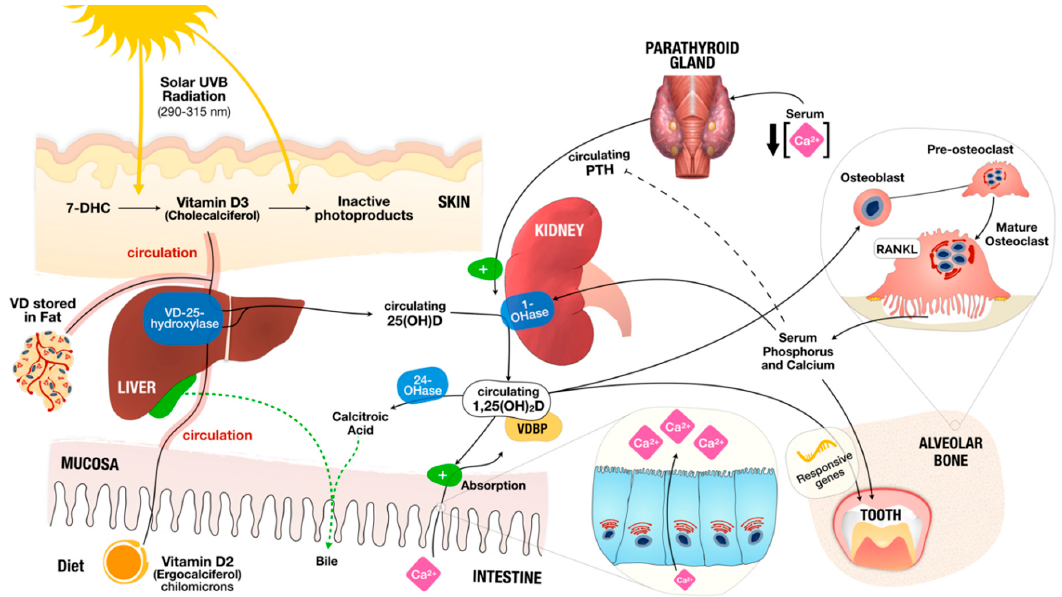
Figure 1. Vitamin D and Calcium, Phosphorus and Bone Metabolism. Vitamin D is obtained mostly from sunlight exposure (Vitamin D3) and from diet (Vitamin D2). In contact to solar ultraviolet B (UVB) radiation, 7-dehydrocholesterol (7-DHC) present in the skin is immediately converted to vitamin D3 in a heat-dependent process. Excessive sunlight exposure can destroy Vitamin D3 and convert it into inactive photoproducts. Vitamin D2 from diet is absorbed in the form of chylomicrons when they spread into the bloodstream as Vitamin D (encompassing Vitamin D2 or D3). Vitamin D in the circulation is bound to the vitamin D–binding protein (VDBP), which transports it to the liver. There, Vitamin D is converted by vitamin D-25-hydroxylase (VD-25-hydroxylase) to 25-hydroxyvitamin D (25(OH)D) (used as standard surrogate to determine vitamin D status). Then, 25(OH)D circulates, reaching the kidneys where it is activated by 25-hydroxyvitamin D-1 α hydroxylase (1-OHase) to 1,25-dihydroxyvitamin D (1,25(OH)2D). Serum phosphorus or calcium can impact renal production of 1,25(OH)2D. 1,25(OH)2D promotes negative feedback of parathyroid hormone (PTH) by the parathyroid glands. 1,25(OH)2D increases the expression of 25-hydroxyvitamin D-24-hydroxylase (24-OHase), upholding its excretion in the bile. 1,25(OH)2D is recognized in the osteoblasts, causing the induction of mature osteoclast through expression of the receptor activator of nuclear factor- κ B ligand (RANKL). Mature osteoclasts remove calcium and phosphorus from the bone, maintaining the serum levels of calcium and phosphorus.